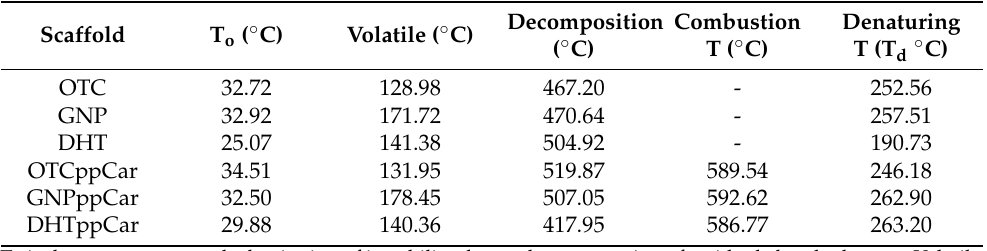
Table 2. Thermal transition temperatures of different groups of OTC biomaterials. T o , onset temper- ature; T d , the denaturation temperature at peak before large weight loss.